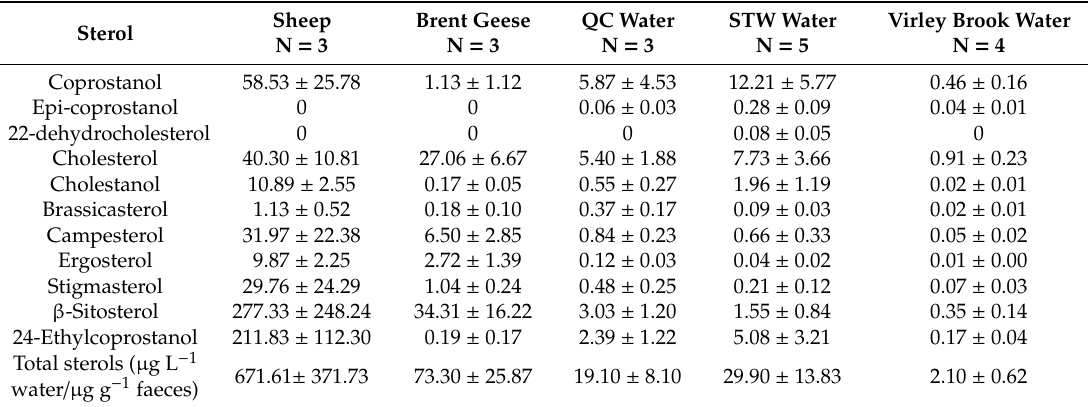
Table 5. Assessment of sterol profiles of potential inputs of faecal material into waters above the oyster beds (mean ± standard error).